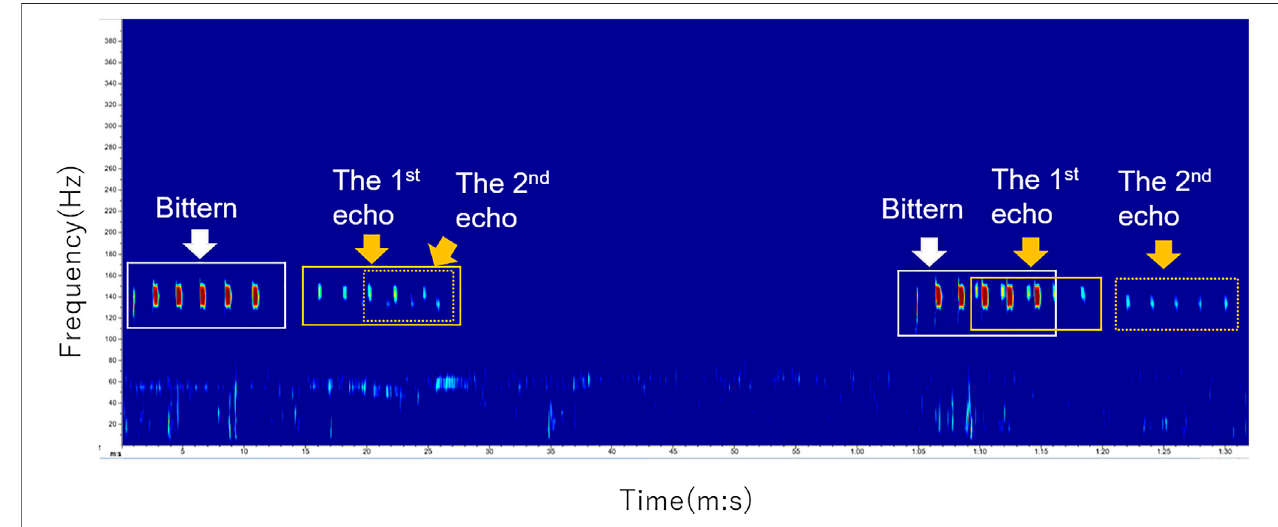
FIGURE 7 | Example spectrograms of bittern calls and echoes.